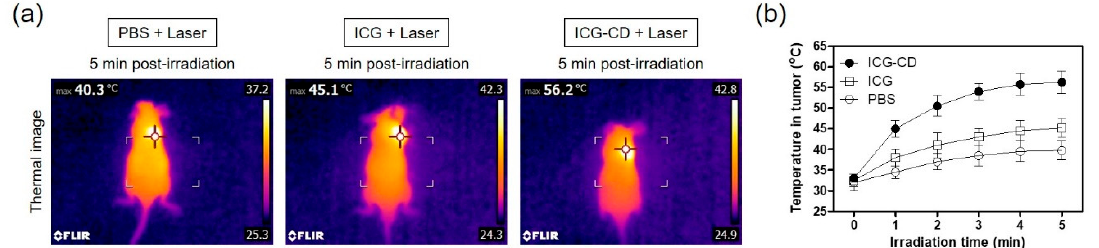
Figure 5. ( a ) Whole-body thermal images of tumor-bearing mice at 4 h post-injection of PBS, ICG, or the ICG-CD complex upon exposure to 808 nm laser irradiation (1.1 W / cm 2 ) for 5 min. The maximum tumor temperatures were automatically recorded with an infrared thermal camera as a function of irradiation time. ( b ) Temperature changes at the tumor sites in each treatment group were monitored during 5 min of 808 nm laser irradiation. Data are expressed as the mean ± S.D. of three independent experiments.